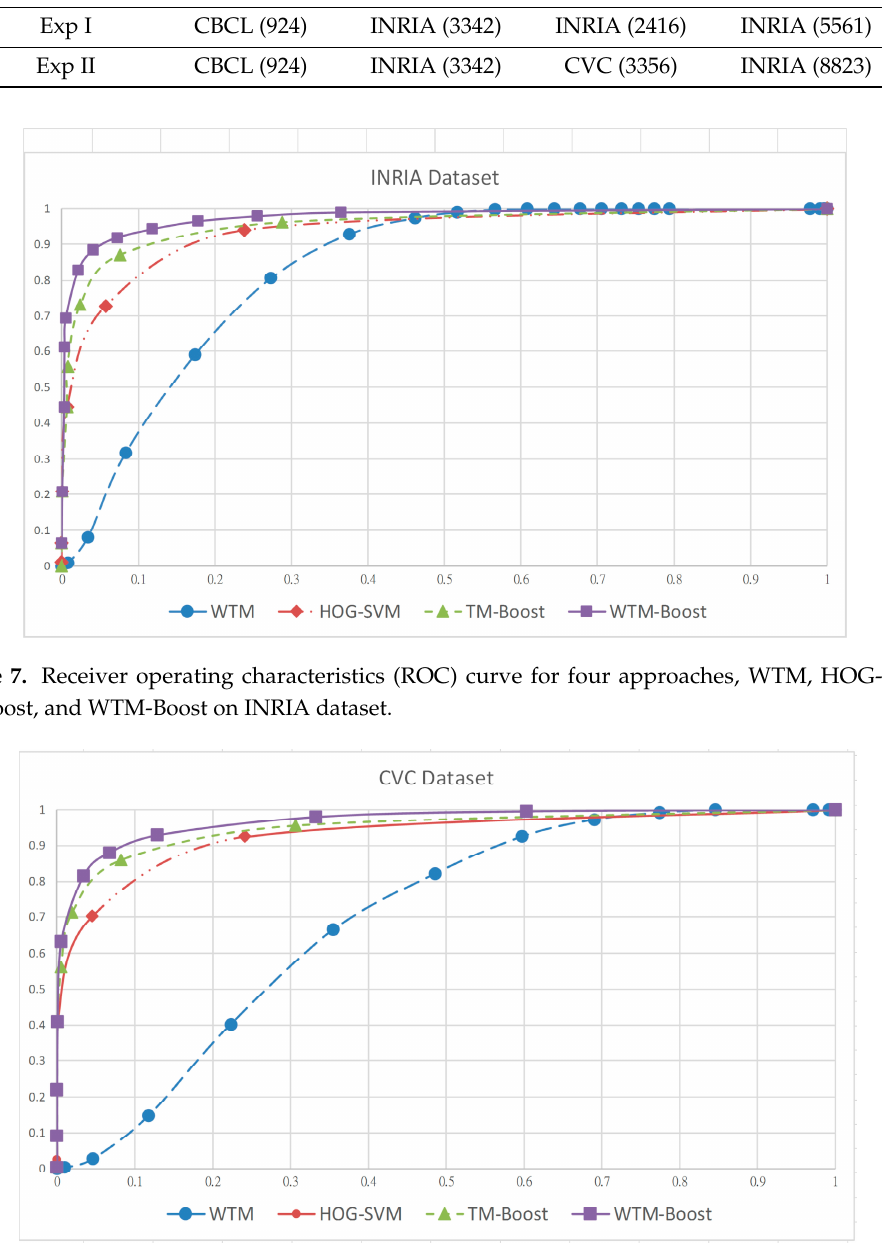
Table 2. Image statistics for training and testing.